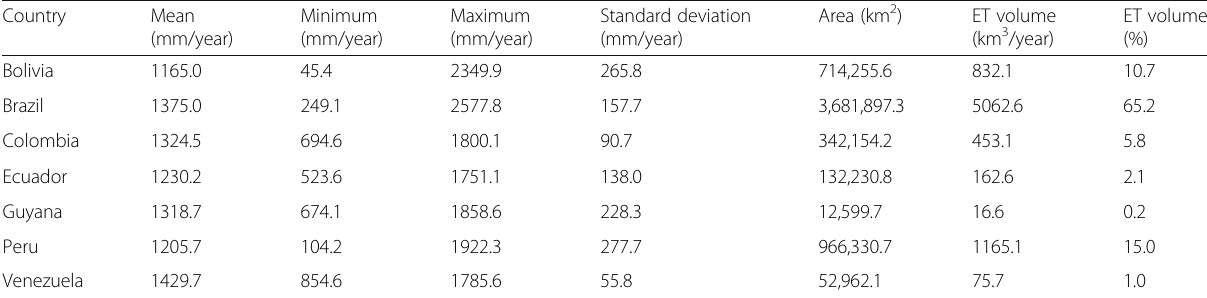
Table 7 Annual ET statistics for the Amazon River Basin presented by country based on a validated ET-Amazon product